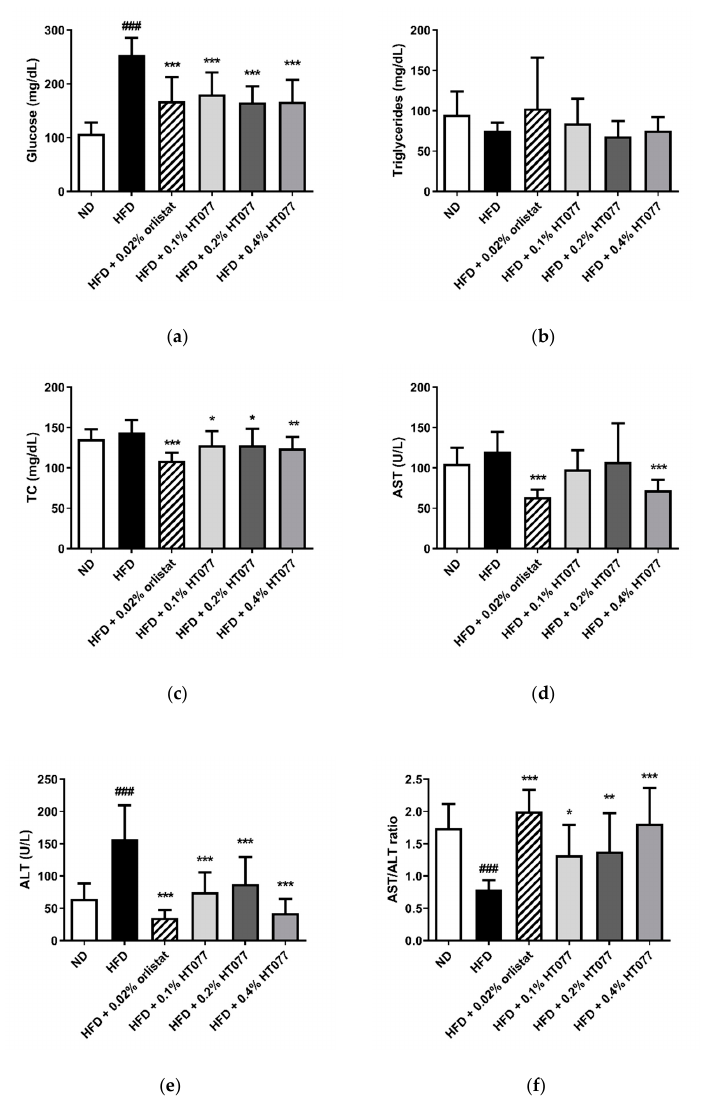
Figure 3. Effects of an extract mixture of Prunus persica and Nelumbo nucifera (HT077) on serum biochemical profiles in C57BL/6 mice fed a high-fat diet (HFD). The levels of glucose ( a ), triglycerides ( b ), total cholesterol ( c ), AST ( d ), and ALT ( e ), as well as the AST/ALT ratio ( f ), were measured. Mice received either a normal diet (ND), HFD, HFD containing 0.02% orlistat, or HFD containing 0.1, 0.2, or 0.4% HT077 for 12 weeks. All values are presented as the mean ± SD ( n = 8 for ND, 16 for HFD, and 12 for the other groups). ### p < 0.001 vs. ND group; * p < 0.05, ** p < 0.01, and *** p < 0.001 vs. HFD control group. ALT, alanine aminotransferase; AST, aspartate aminotransferase; TC, total